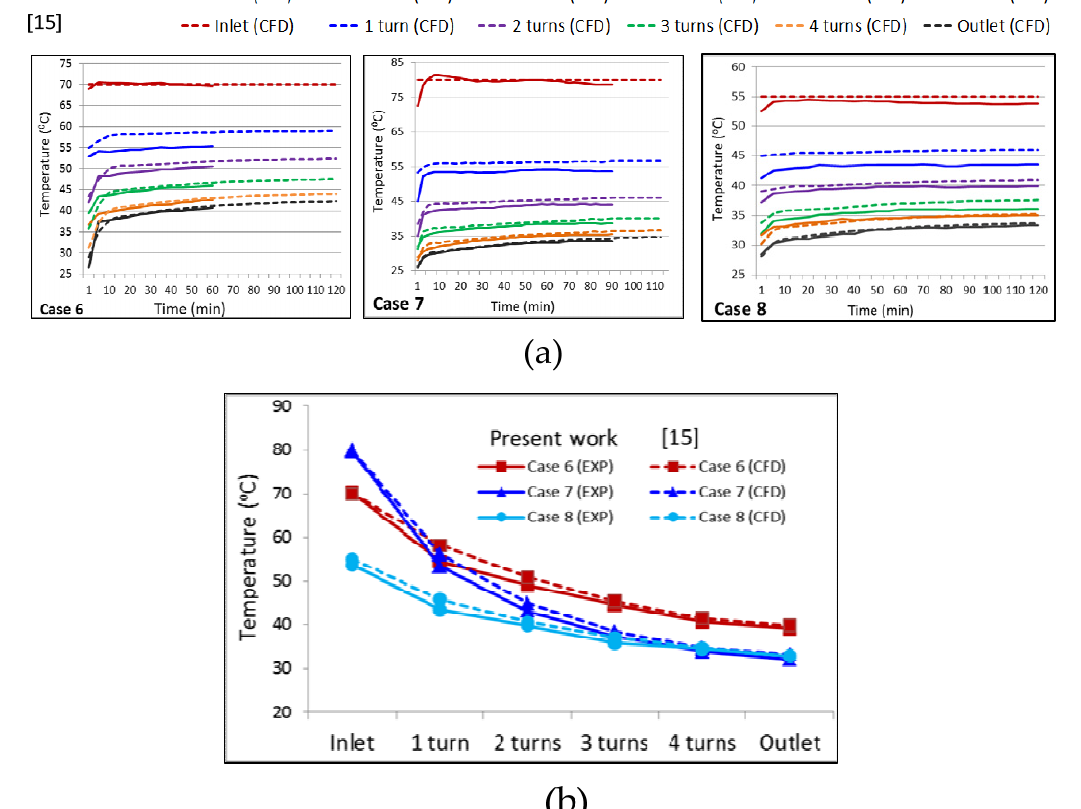
Figure 9. Comparison between the experimental and CFD results of the hot liquid moving along the HCT from cases 6, 7, and 8. ( a ) Temperature variations during heat transfer. ( b ) Temperature at the selected points when the water in the fish tank was heated to 28 °C.